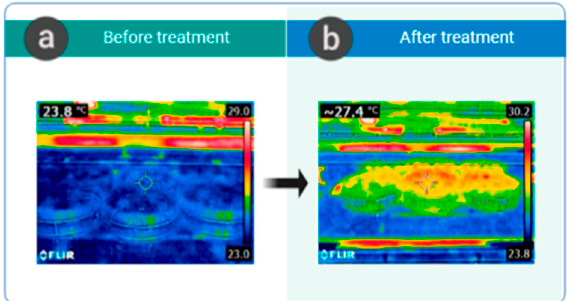
Figure 3. Temperature increase on the surface of table grapes after 5-pulses treatment. ( a ) temperature on the surface before pulses, and ( b ) temperature after pulses